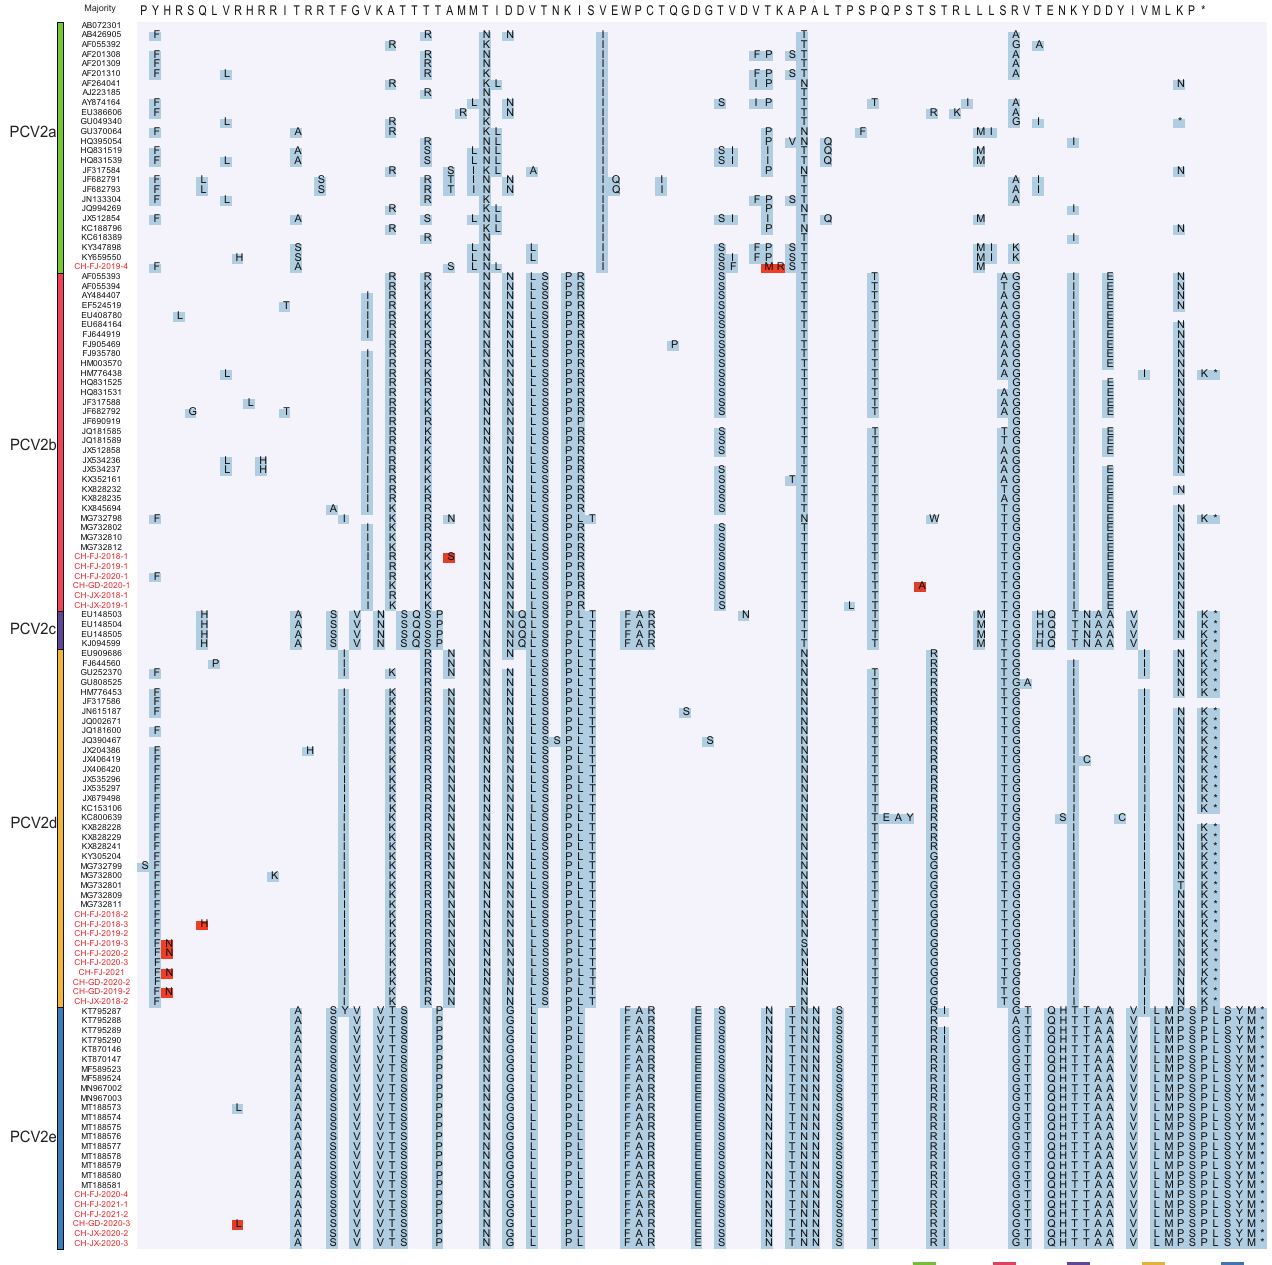
Figure 3. Analysis of amino acid variation of the PCV2 Cap protein. Pairwise alignment of the amino acid of 104 PCV2 cap protein reference strains and 23 sequenced strains. The residues that are the same as the first reference sequence are not marked; only the different residues are listed and distinguished by different background colors. The strains sequenced here, and the variants only found in this study, are highlighted in